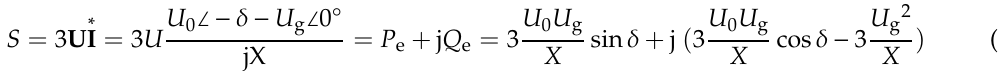
Figure 3. Equivalent diagram of grid-connected VSG.